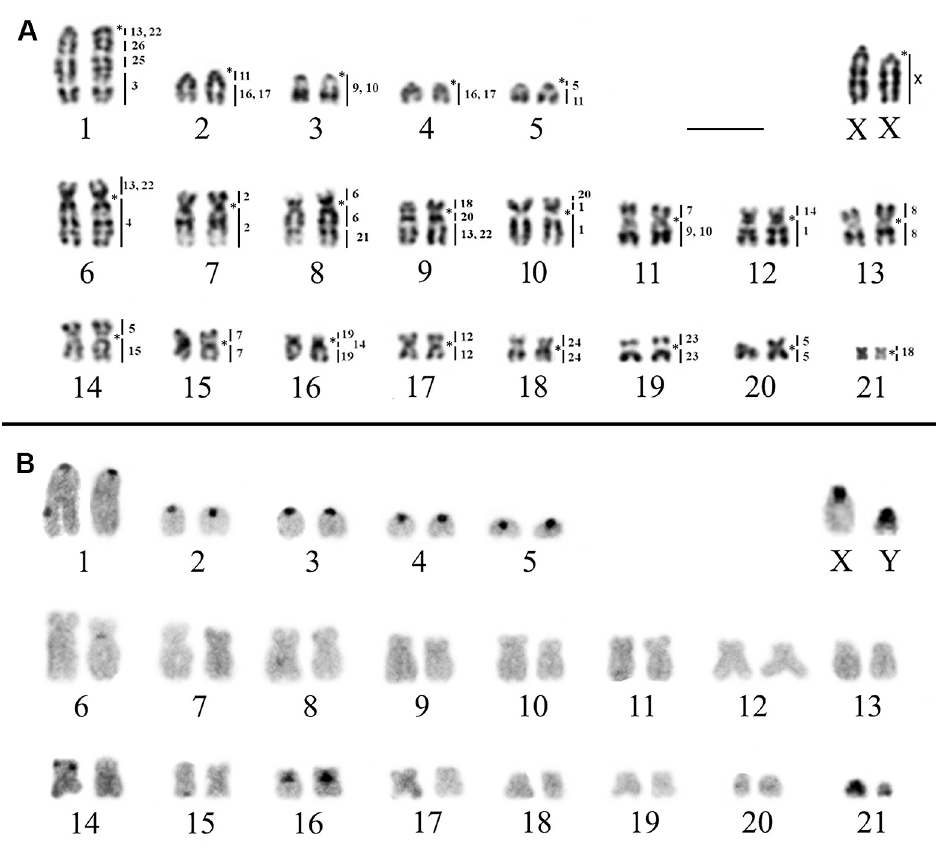
Fig 3. Karyotype of R . mastacalis (RMA, 2n = 44, FN = 74). A) G-banding with genomic mapping using whole chromosome probes of H . megacephalus . B) C-banding showing the location of the constitutive heterochromatin. ( � ) Indicates centromere. Bar: 10 μ m.